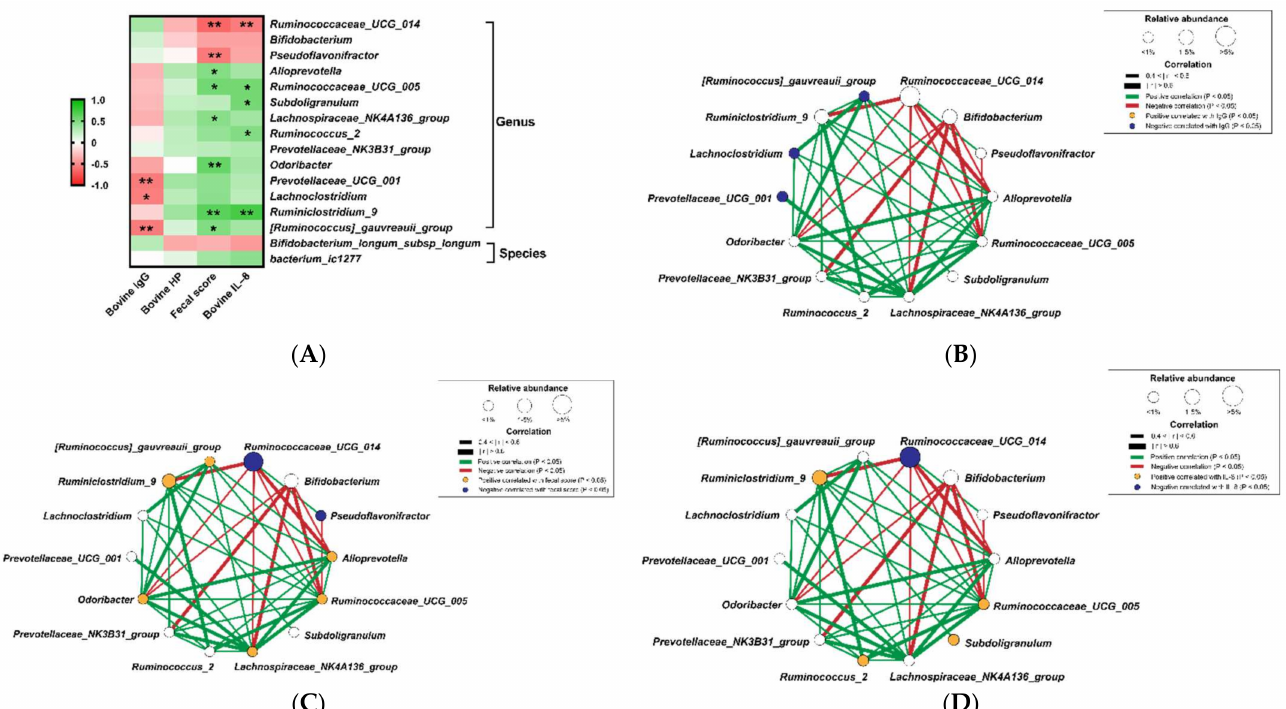
Figure 3. ( A ) Spearman’s correlation test between diarrheic biomarkers and calf gut microbial markers at genus and species level. Each cell was colored corresponding to Spearman’s correlation results. Significant difference: * p < 0.05; ** p < 0.01. Bacterial networks between calf gut microbial markers at genus level and their correlation with ( B ) bovine IgG, ( C ) fecal score or ( D ) IL-8 (Continued). Each node represents a genus biomarker, and the size of it corresponds to relative abundance. Colored nodes show significant correlation with IgG, fecal score or IL-8 ( p <